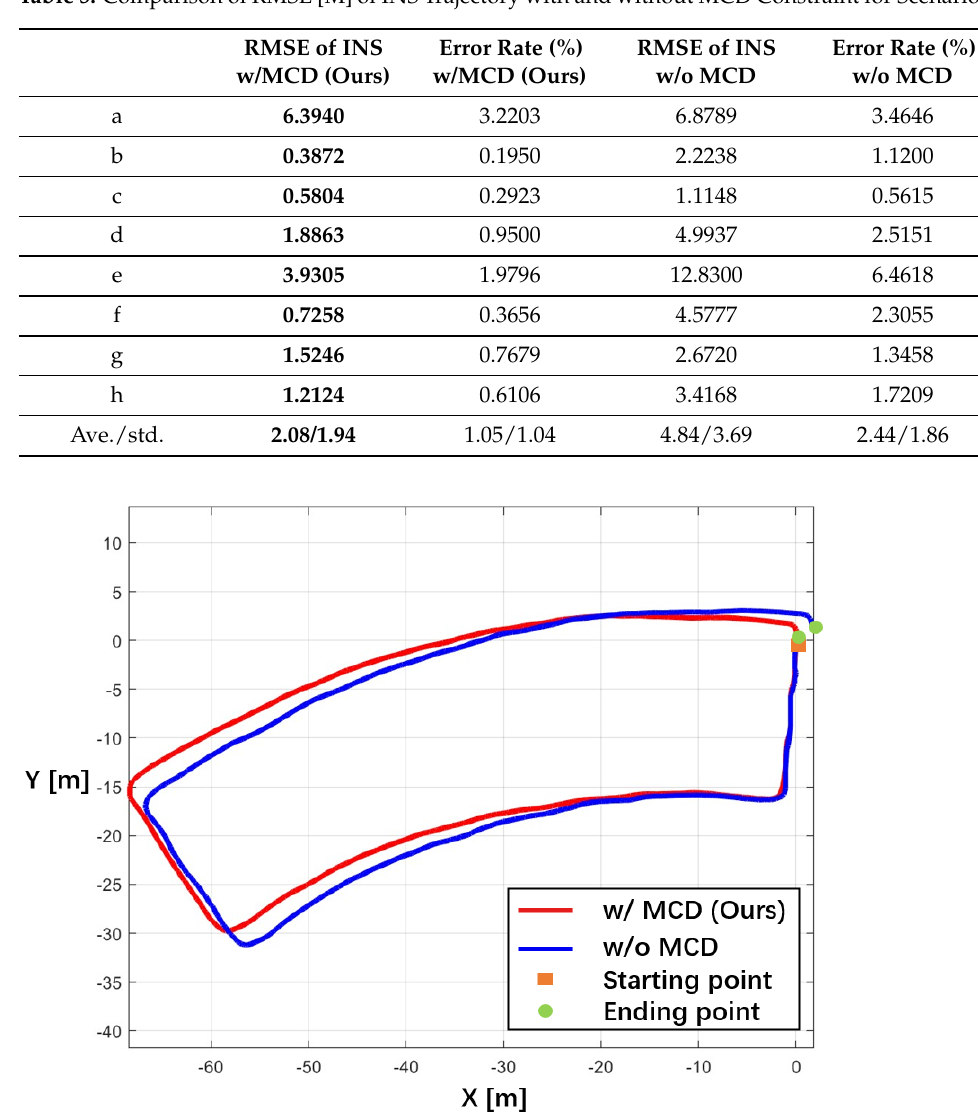
Figure 11. 2D plotting of the fused trajectory with MCD (red line) and without MCD (blue line) of Scenario2 participant